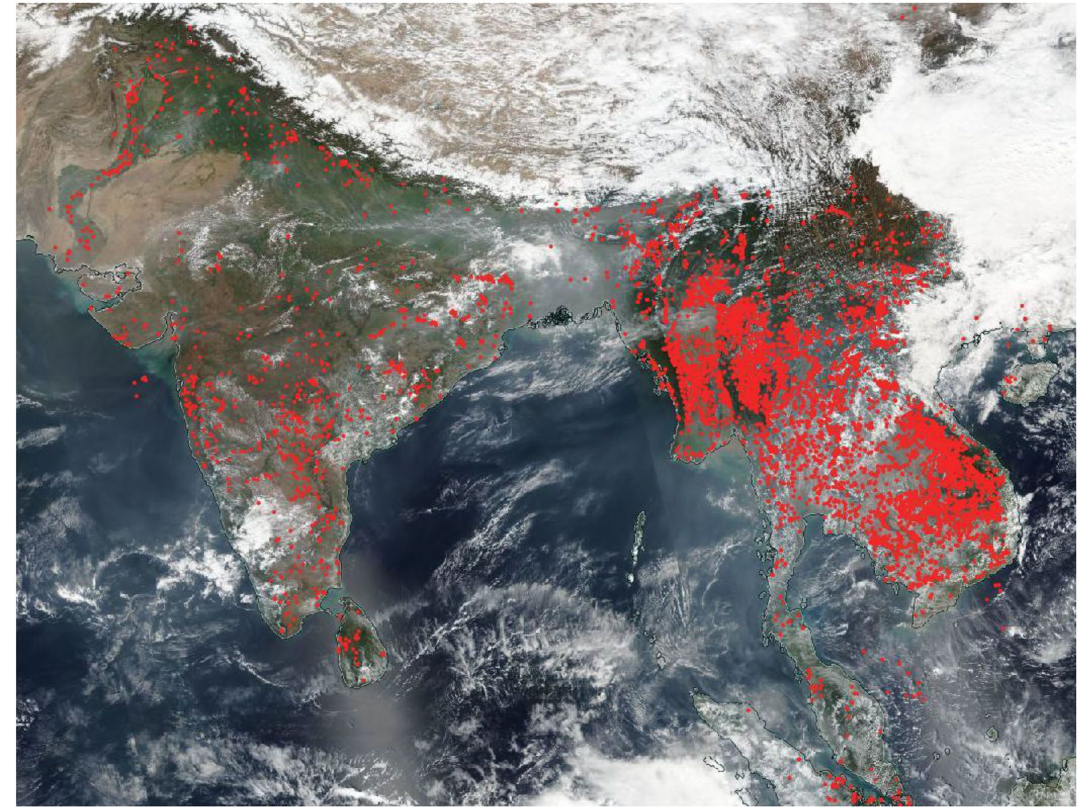
Figure 1. Suomi NPP/VIIRS fires and thermal anomalies shown as red dots (Day and Night) on March 02nd, 2020. The background image is NOAA-20/VIIRS corrected reflectance with true color (Red = Band I1; Green = Band M4 and Blue = Band M3). The VIIRS instrument is aboard the joint NASA/NOAA NOAA-20 (JPSS-1) satellite. (Imaged generated using opensource free NASA WorldView system (https:// world view. earth data. nasa.